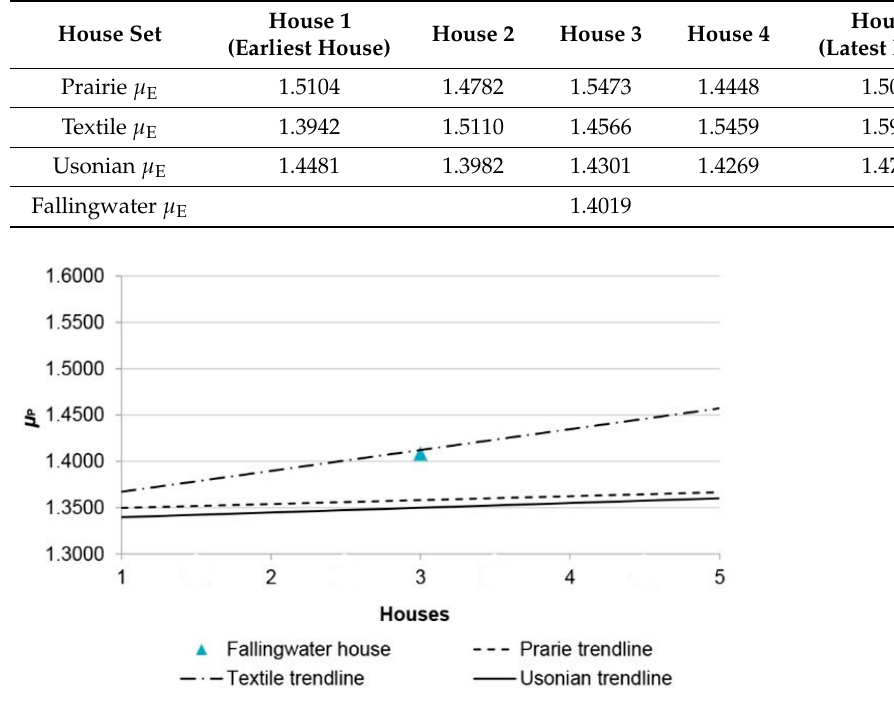
Figure 6. Linear trendline data for elevations of the stylistic periods (arrayed, from left to right, in order from earliest to latest in each style) compared with Fallingwater. Table 4. All houses, elevation data, in chronological order.